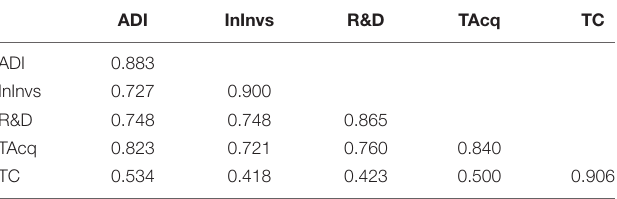
TABLE 4 | Fornell and larcker